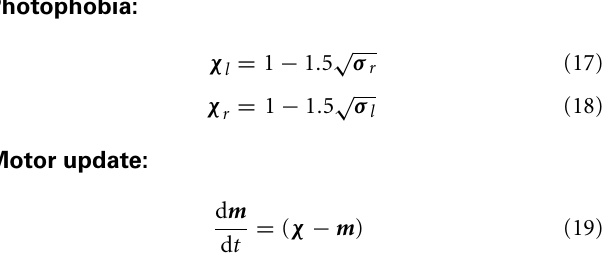
column. Robots are relocated to a random position and assigned a random motor-state every 50 time-units. The light is fixed at the center of the arena. The bar chart shows the mean distance of the robot from the light for each behavior during each indicated